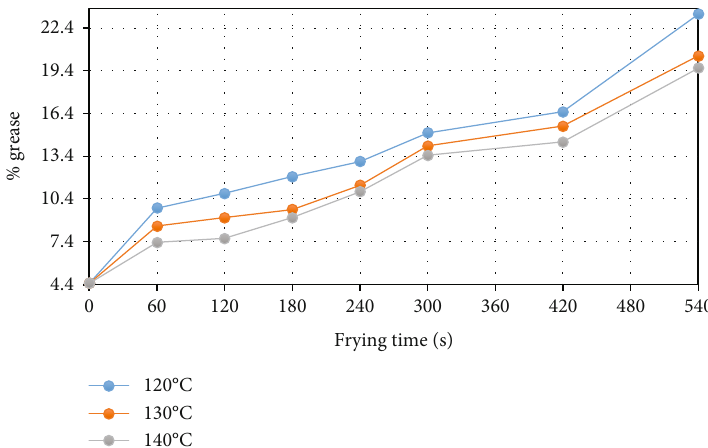
Figure 3: Kinetics of oil uptake during the vacuum frying of the Colombian Coastal Carimañola. The values are averages ± standard deviation